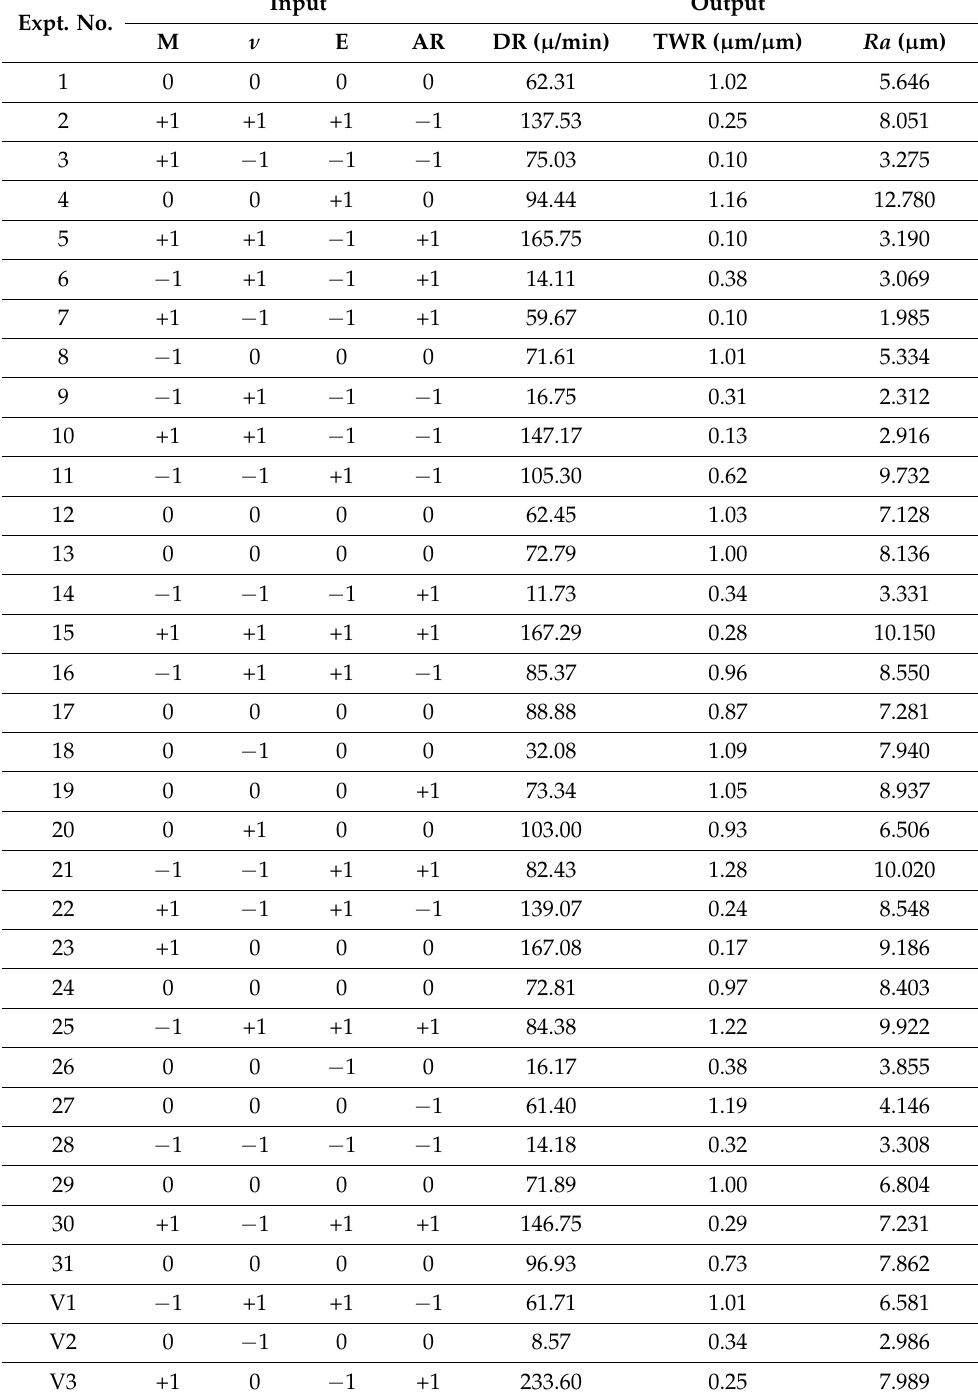
Table 2. Input–output